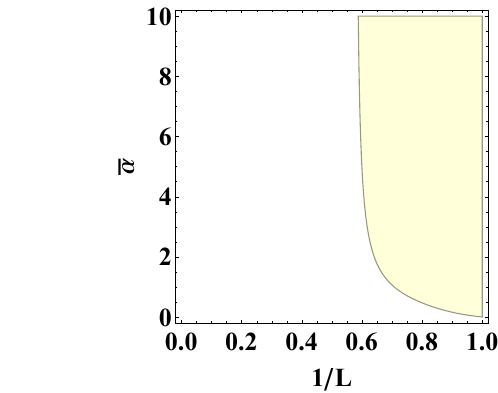
Figure 2 . The unstable regions of the de Sitter Gauss-Bonnet black hole. The left panel shows the unstable region in ( L; (cid:11); ‘ ) space. Note that ‘ = 2 ; 3 ; : : : , here for simplicity we take ‘ to be continuous in this plot and in (cid:12)gure 3. The right panel shows the unstable region with ‘ = 2 in light